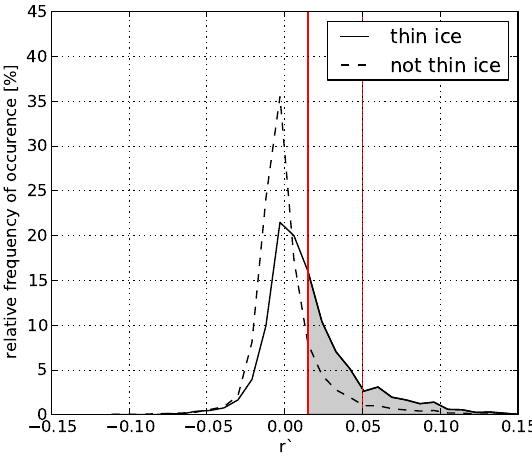
Fig. 3. Frequency distribution of r 0 values for the scene in Fig. 5a. The red lines mark the lower and upper tie-points r 0 Eq.